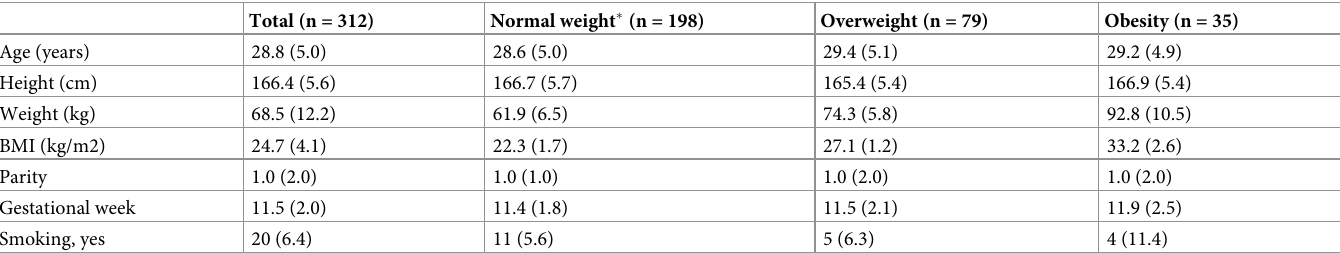
Table 1. Characteristics of women at time of enrollment at the antenatal clinic in Lidko ¨ ping 1999 presented in body mass index (BMI) classification